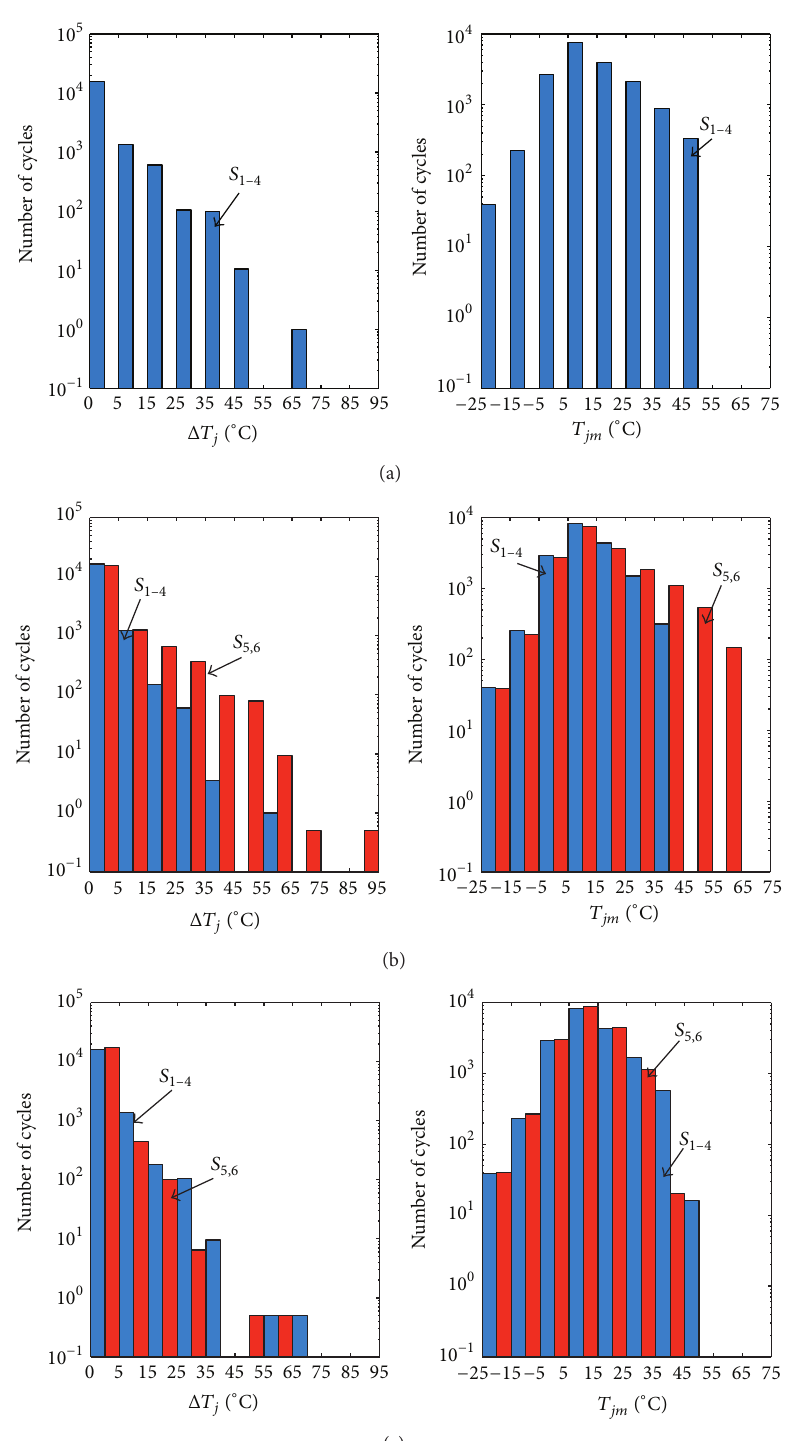
Figure 10: Rain-flowing counting results (number of cycles distributions at the cycle amplitude Δ𝑇 𝑗 and the mean junction temperature 𝑇 𝑗𝑚 ) of the thermal loading profiles shown in Figure 8: (a) FB-Bipolar inverter, (b) H6 inverter, and (c) HERIC